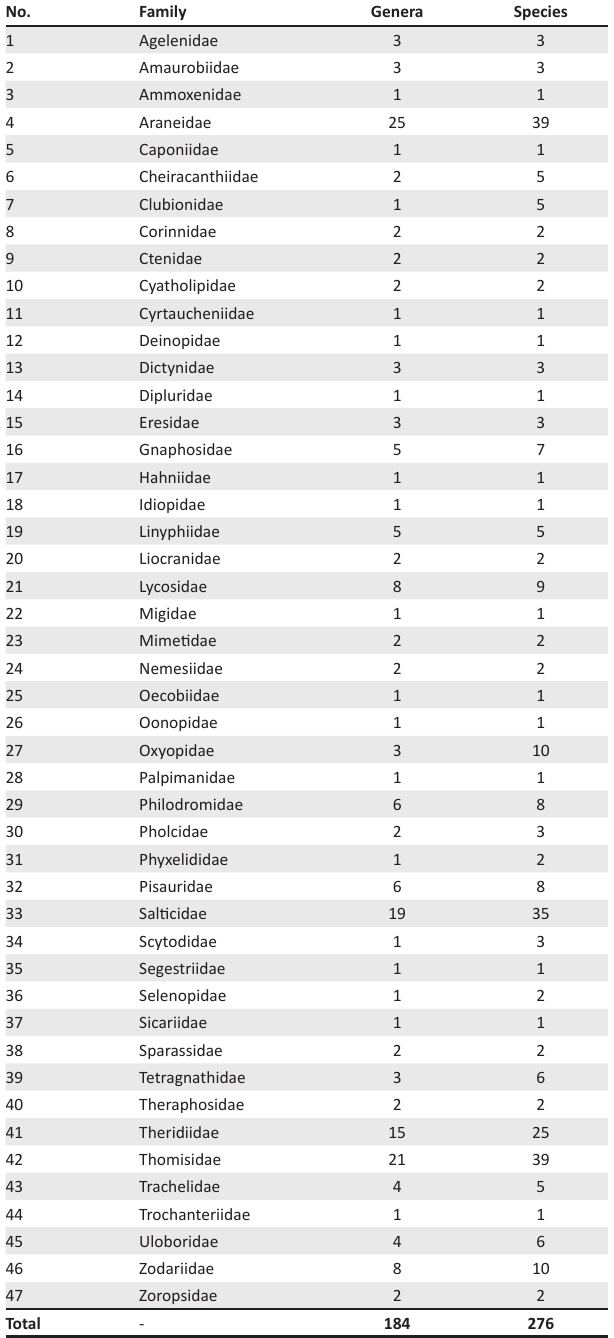
TABLE 1: Spider diversity of the Addo Elephant National Park, with the total number of families, genera and species sampled. No. Family Genera